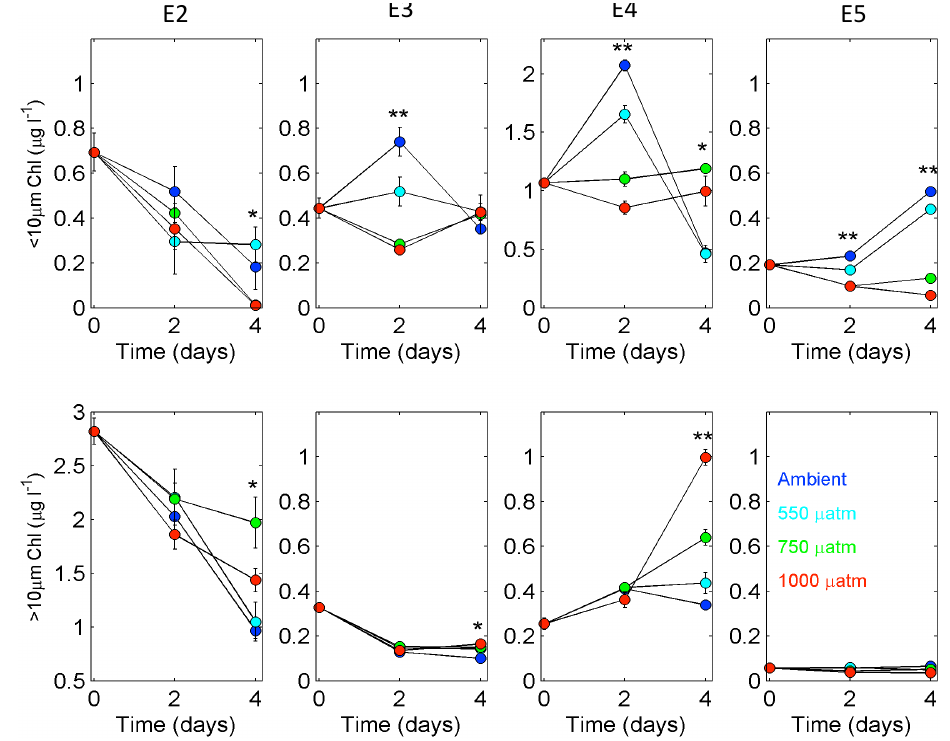
Figure 8. Time series measurements of size-fractionated Chl a ( < 10µm and > 10µm) (µgL − 1 ) from main experiments (E2–E5). At each time point, statistical differences between treatments were evaluated using one-way ANOVA followed by a Tukey-Kramer means comparison test. Sets of measurements where at least one treatment was statistically different ( p < 0.05) are indicated by “*”, while sets where there is a clear progressive response as a function of treatment (i.e. where at least three groups could be distinguished between the four incubation conditions and where the effect consistently increased/decreased as a function of p CO 2 /pH) are indicated by